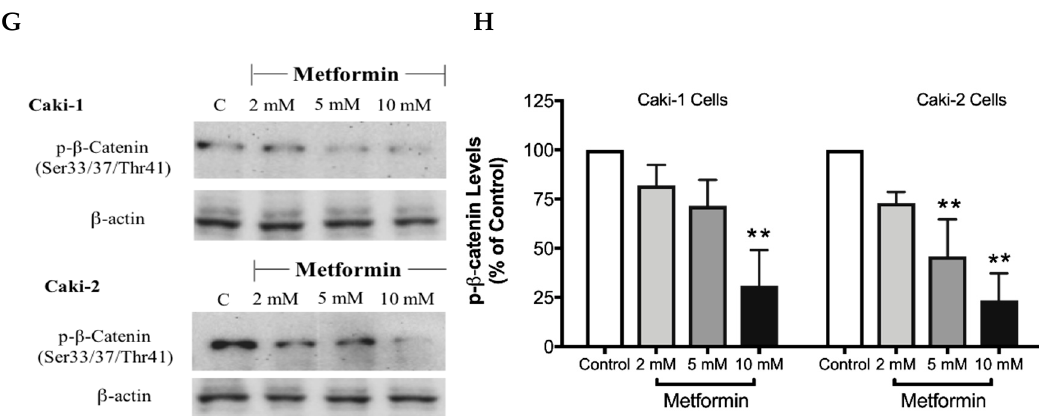
Figure 8. Metformin inhibited Wnt/ β -catenin signaling in both Caki-1 and Caki-2 renal cancer cells. Western blot analyses are shown for ( A , B ) Wnt3a, ( C , D ) p-LRP6 (Ser1490), ( E , F ) GSK-3 β (Ser9) and ( G , H ) p- β -catenin (Ser33/37/Thr41) protein in Caki-1 and Caki-2 cells incubated in the absence (control) or presence of metformin (2, 5, and 10 mM). Images are representative of three independent experiments per group. ( B , D , F , H ) Histograms represent pooled densitometry data normalized to β -actin expressed as the percentage of control. Data are presented as mean ± SEM. * P < 0.05; ** P < 0.001; and *** P < 0.0001 vs. control.